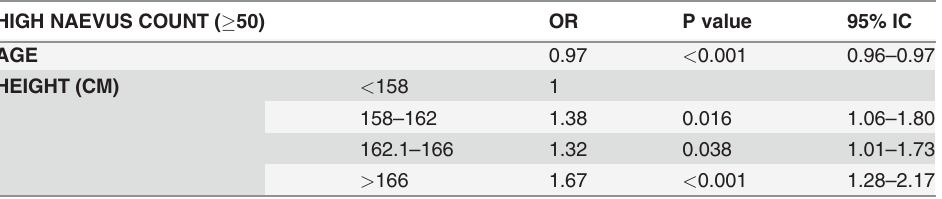
Table 1. Logistic regression on risk factors for HNC (total naevus count equal or above 50) in relation to increasing height. (Robust regression) (n =